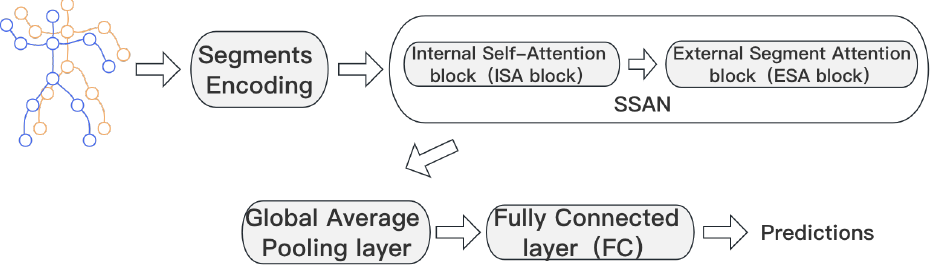
Figure 1. Illustration of the overall architecture of the proposed method. The segments encoding module rejoins the skeleton sequence segments and encodes them into a data format that has been added to the location ID. The ISA block is used to obtain the relationship of the node to different nodes within adjacent frames. The ESA block is used to integrate all the decomposed actions. Finally, the classification scores are obtained through the global average pooling layer and the full connection